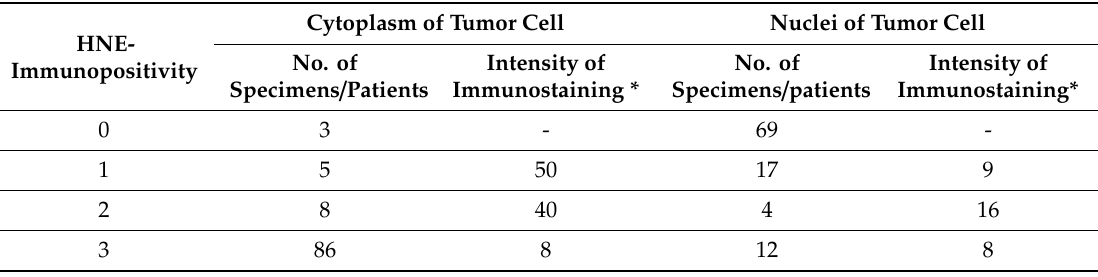
Table 1. Semiquantitative analysis of the HNE-immunopositivity and intensity of immunochemical reaction in malignant